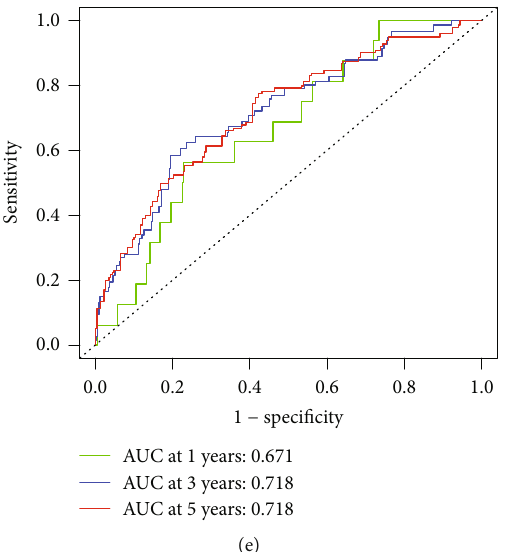
Figure 2: Correlation between predictive risk signature constructed by 7 necroptosis-associated lncRNAs and prognosis of BRCA patients. (a) Kaplan-Meier curve analyzed OS rates in high- and low-risk BRCA patients (b) Heat map of expression of 7 lncRNAs. (c) Risk score distribution in BRCA patients (d) Survival status of patients with di ff erent risk scores. (e) ROC curve and area under the curve at long-term